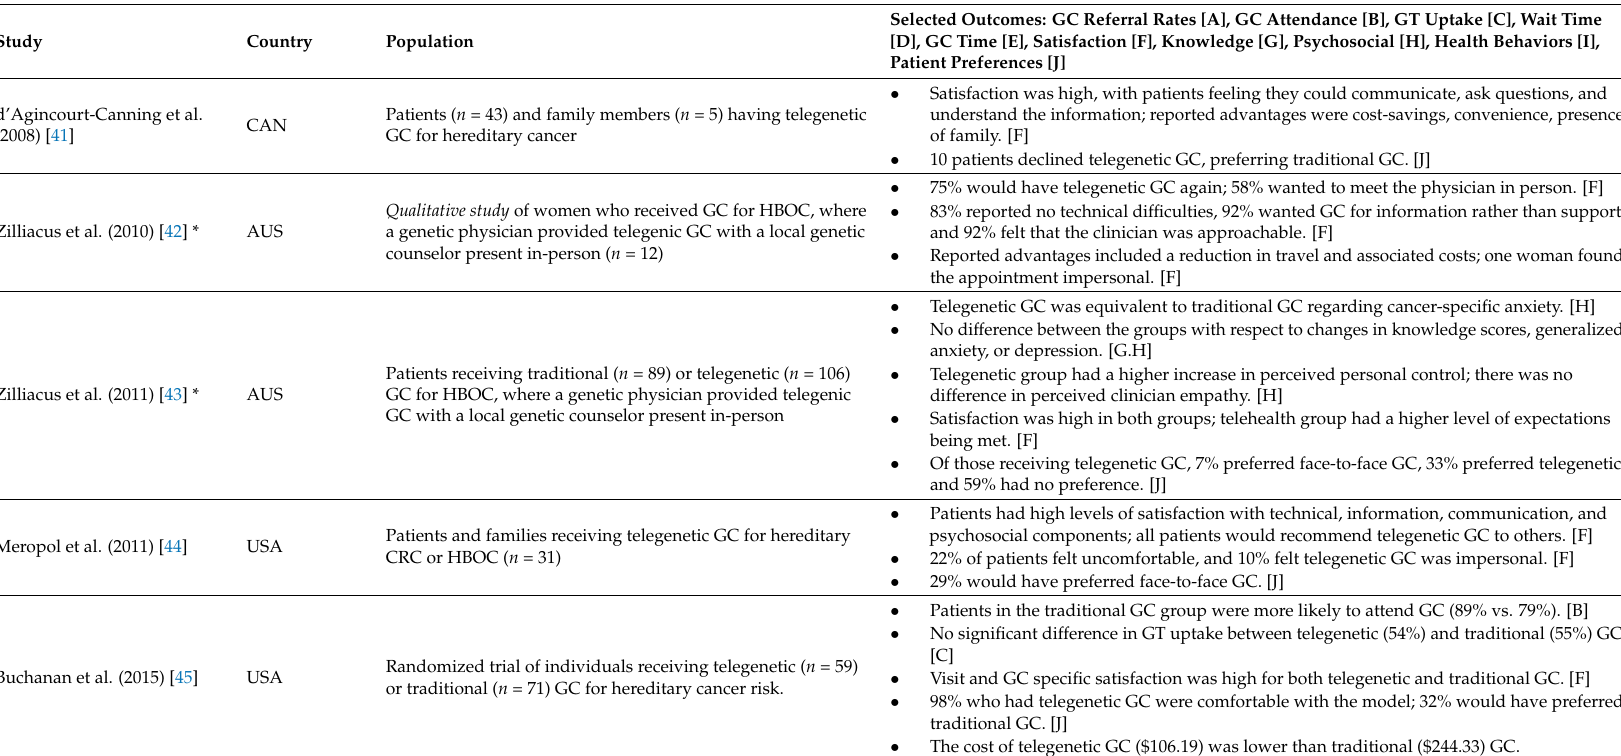
Table 2. Telegenetic genetic counseling